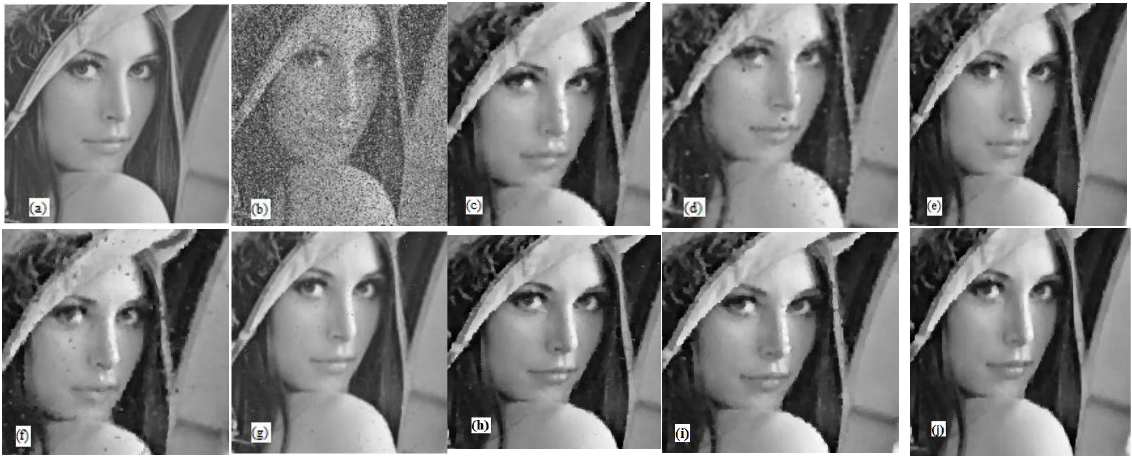
Figure 8. ( a ) Shows zoomed Lena image. ( b ) Noisy image with 40% RVIN. De-noised images using